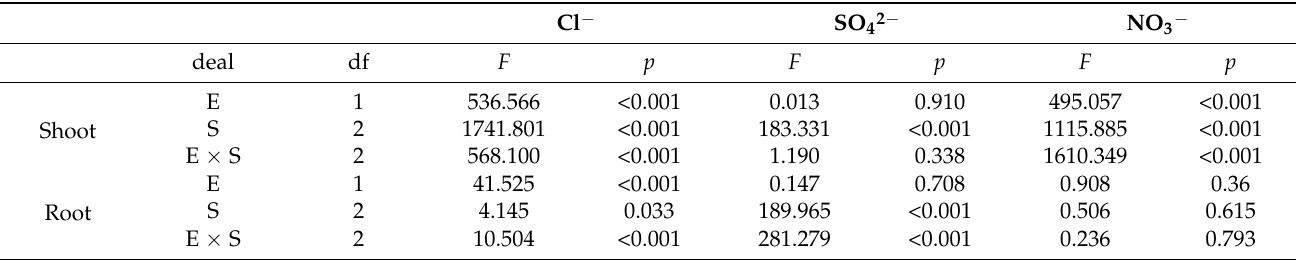
Figure 2. Effects of different alkali concentrations on Cl − ( A , B ), SO 42 − ( C , D ) and NO 3 − ( E , F ) contents in E+ and E − H. bogdanii shoots and roots.Note: Among different groups, when comparing the same E+ or E − plant, different lowercase letters of the column mark indicate a significant difference ( p < 0.05); in the same group E+ compared with E − , * indicates a significant difference ( p < 0.05). Table 3. Two − factor ANOVA of the effect of Epichloë endophytic fungi on Cl − , SO 42 − and NO 3 − contents in H. bogdanii under alkali